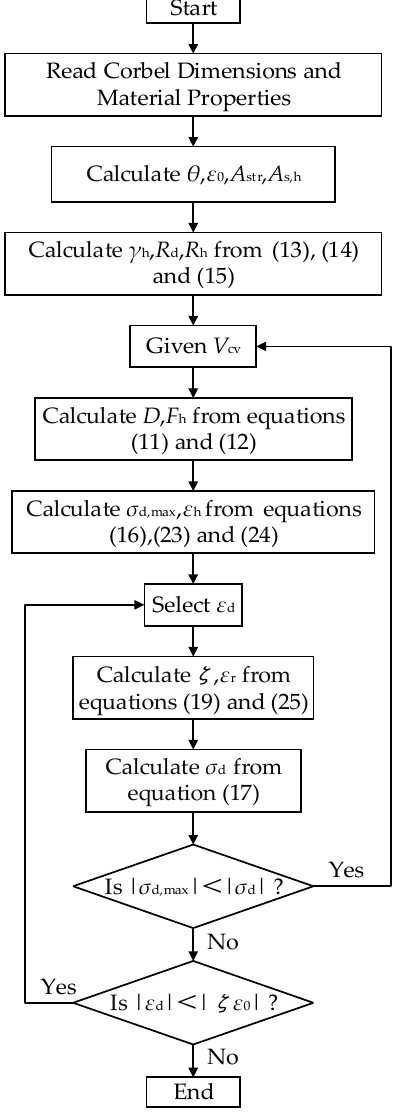
Figure 6. Implementation flowchart for the shear-bearing capital of corbels. To validate the rationality of the calculation model for the shear-bearing capacity of steel-fiber concrete corbels proposed in this paper, data from a total of 26 steel-fiber concrete corbels were collected from both tests and the literature [22]. The proposed model was used to calculate the shear-bearing capacity of the tested specimens and compared with the various theoretical models, including the ACI-318, EC2, CSA A23.3-19 and the softened strut-and-tie model. Table 5 represents a comparison between the experimental shear strengths of all tested specimens and the shear strengths calculated by the various models, i.e., the ACI code, CSA code EC2 code, and the strut-and-tie model. The means of the predicted values were 1.611, 1.624 and 1.710, with the variances of 0.072, 0.038 and 0.057, respectively. The codes provided conservative estimates of the load-carrying capacity because they did not consider the contribution of the steel fibers in the resisting shear. The mean values calculated by the softened strut-and-tie model and the proposed model were 1.183 and 1.082, with the variances of 0.007 and 0.004, respectively. In comparison to the results of the softened strut-and-tie model, the results obtained with the proposed model were closer to the experimental values. The proposed model results showed a good